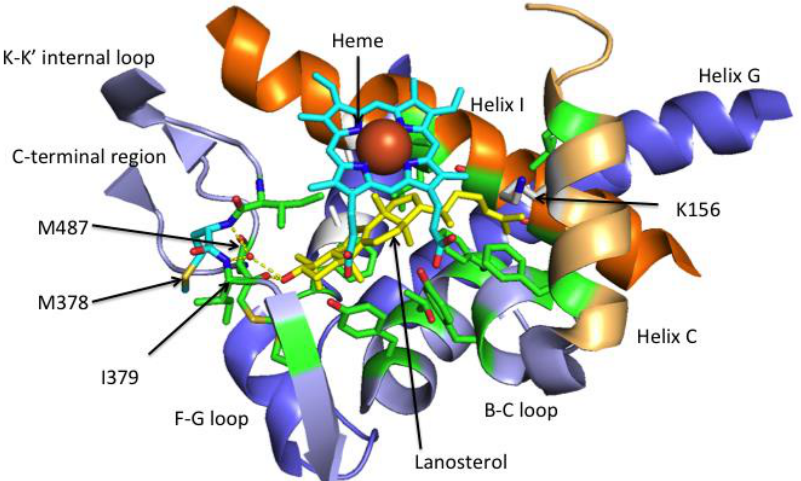
Figure 4. Lanosterol in the ligand-binding pocket (LBP) of CYP51. Relevant portions of the human HsCYP51 crystal structure (Protein Data Bank (PDB) 6UEZ) are shown. Residues within 4 Å of lanosterol (yellow) are shown with carbon atoms in green. These 16 residues are found in helix I, helix B, helix C, the B-C loop, the K-K’ internal loop and the C-terminal region. Proton channel S mutations, D231A in helix F and H314A in nearby helix I, are shown in white. Upon lanosterol binding helix C has changed conformation slightly, the K156 side chain loses its ionic